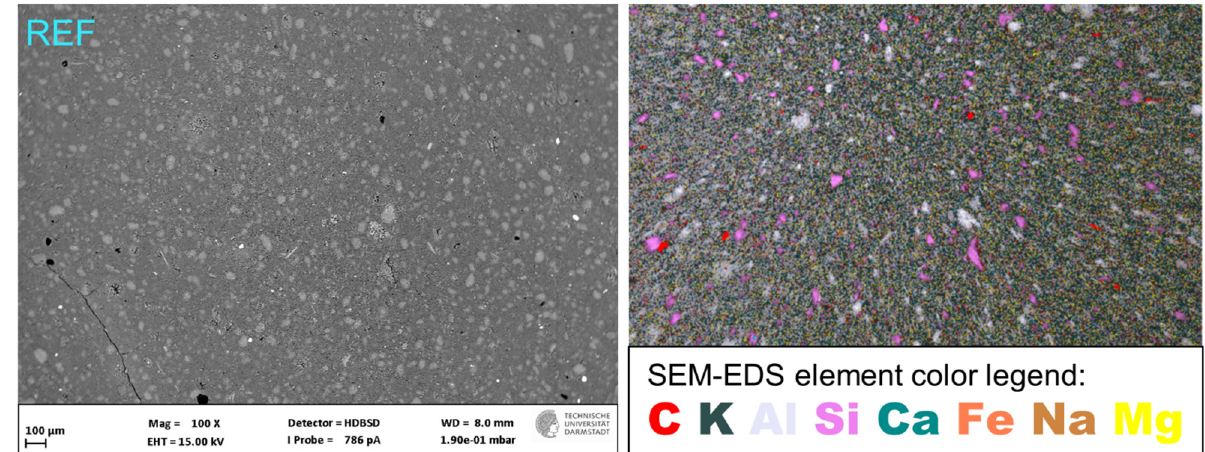
Figure 5. SEM ‐ BSE (left) and elemental mapping (right) for the reference geopolymer.